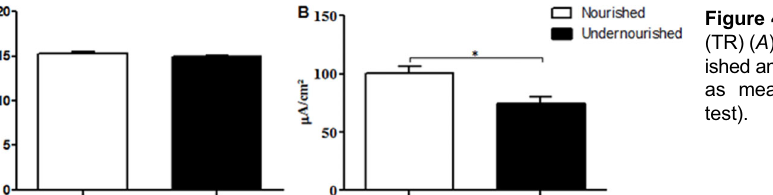
Figure 4. Comparison of transepithelial resistance (TR) ( A ) and basal short circuit current ( B ) for nour- ished and undernourished groups. Data are reported as means ± SE (n=4). *P o 0.05 (Mann-Whitney